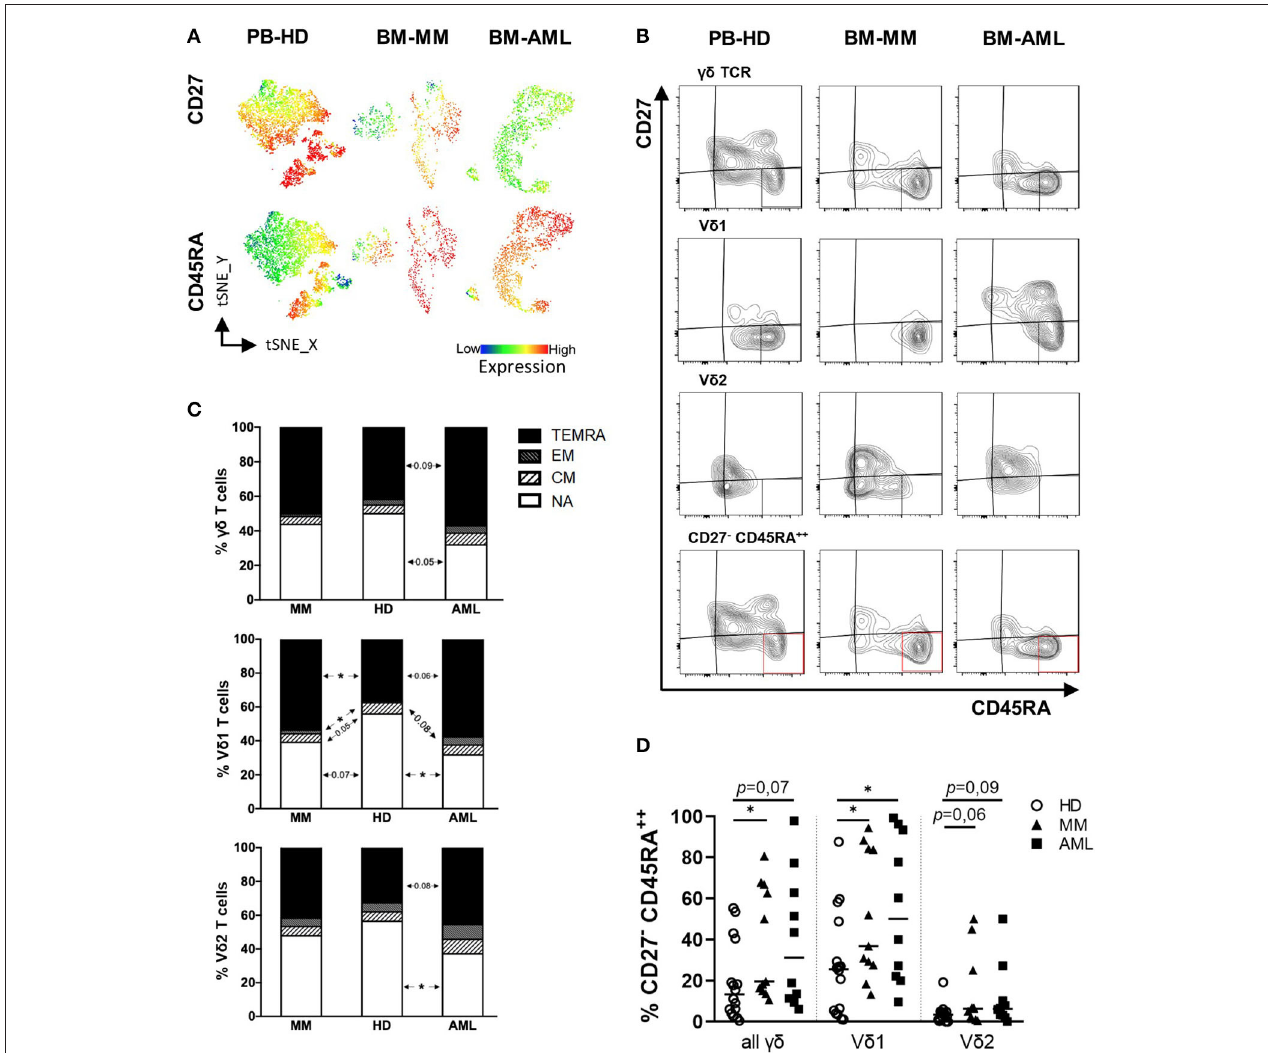
FIGURE 2 | V δ 1 γδ T cells from patients with AML and MM show a shift toward increased EM and TEMRA differentiation. γδ T cell differentiation was analyzed by expression of CD45RA and CD27 for healthy donors (HD, white circles, n = 16), patients with multiple myeloma (MM, black triangles, n = 11) and newly diagnosed AML patients (AML, black rectangles, n = 10). CD27 + CD45RA + : naïve (NA); CD27 + CD45RA − : central memory (CM); CD27 − CD45RA + : effector memory (EM); CD27 − CD45RA + : terminally differentiated (TEMRA). (A) T-distributed stochastic neighbor embedding (tSNE) analysis illustrate the differentiation status of V δ 1 and V δ 2 γδ T cells within the total γδ T cells in BM aspirates from four HDs (left graphs), four patients with MM (middle graphs), and four patients with AML (right graphs). (B) Representative flow cytometry data show the differentiation of γδ T cells. (C) Summary data are demonstrating the distribution of the differentiation status of γδ T cells. The upmost graph shows the subsets of all γδ T cells, followed by V δ 1 and V δ 2 cells only. (D) Displays the frequency of CD27 − CD45RA ++ cells in all γδ T cells and V δ 1 and V δ 2 only. P -Values were obtained by the Mann-Whitney test. * P < 0.05, ** P < 0.01, *** P <